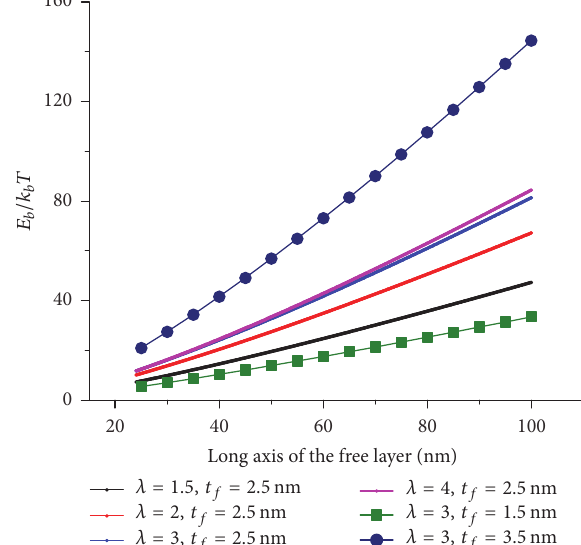
Figure 8: Geometric dependence of thermal stability.